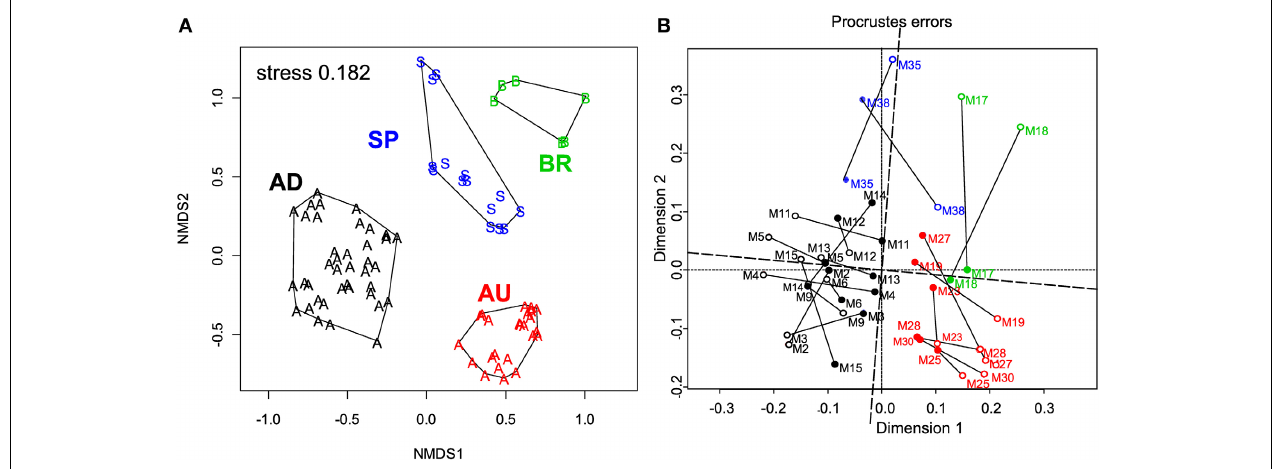
FIGURE 5 | (A) Variation in the microbial community composition within the cyanobacterial layers of the studied mats. A Bray–Curtis dissimilarity matrix was calculated based on ARISA community profiles and is displayed in a 2D ordination space (associated stress value of 0.182). Grouping lines were added for each site a posteriori to highlight the site specificity in the community patterns. (B) Procrustes analysis of the link